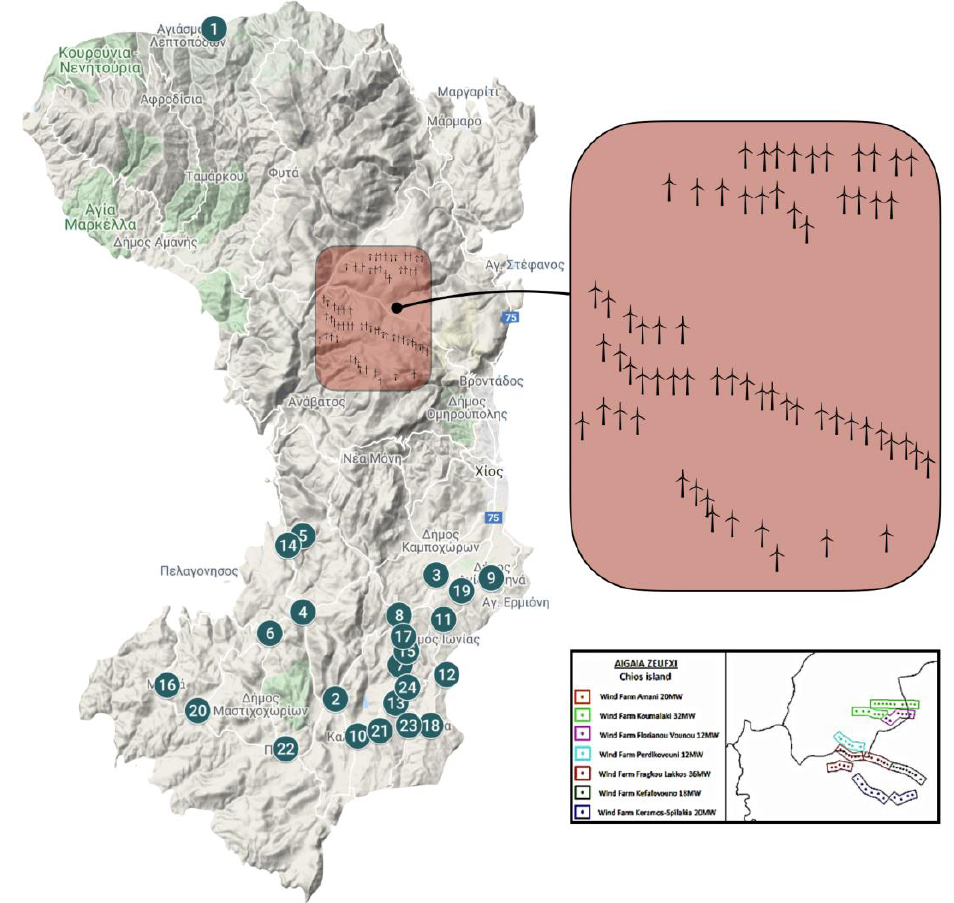
Figure 1. Chios island and the 24 “Mastichochoria” (mastic villages). In red color, the AIGAIA ZEUXI project area location at the map and the wind farms layout.